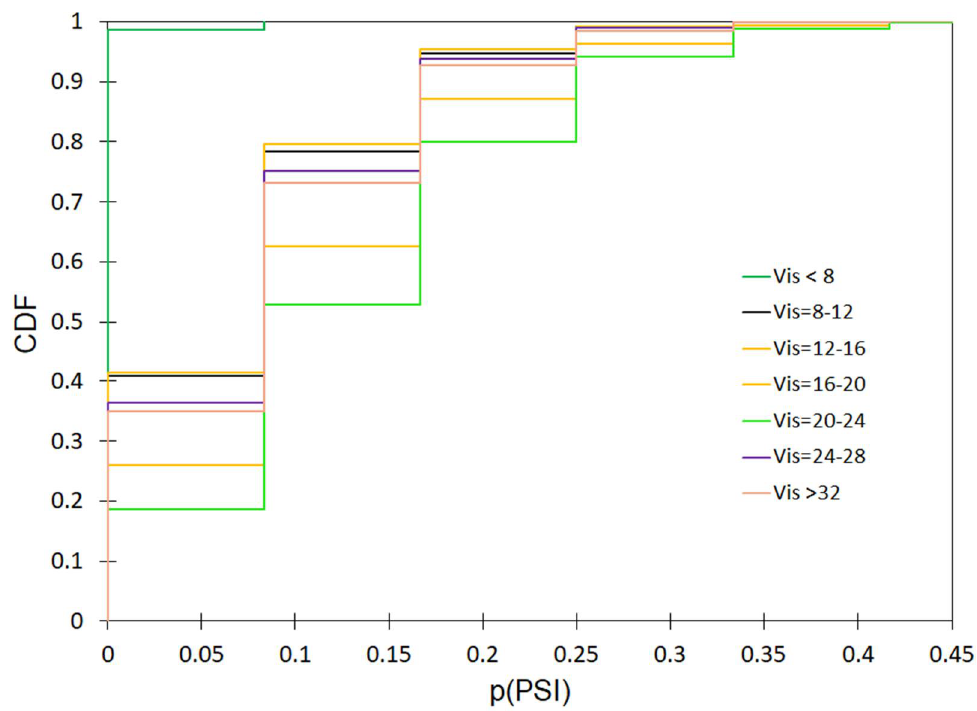
Figure A36. Effect of visibility on the incidence of low spring mortality for rainy days.